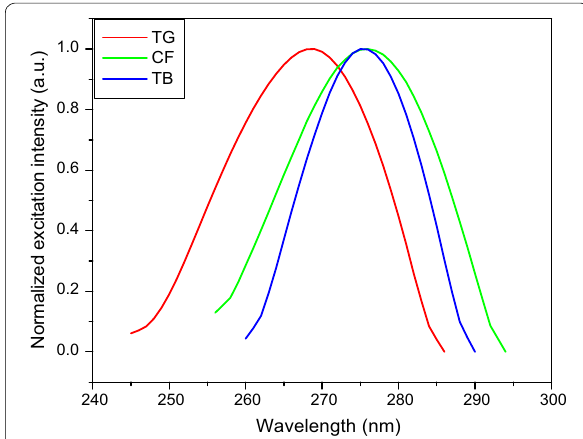
Fig. 7 Fluorescence excitation spectra of coffee alkaloids in the aqueous extract of green coffee beans. TG trigonelline, CF caffeine, TB theobromine